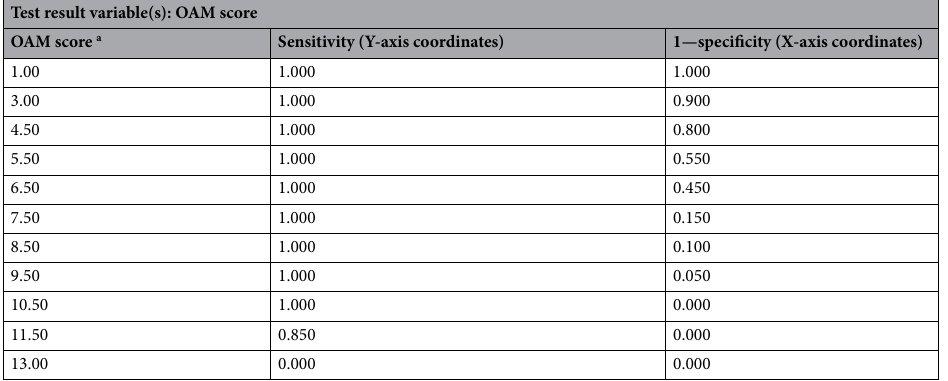
Table 7. Sensitivity and 1-specificity values at different AMS, calculated on the basis of the ROC curve (Coordinates of the curve) in S–S kinship analysis by X-STR. The smallest OAM cutoff score value is the minimum observed test value minus 1, and the most considerable cutoff value is the maximum perceived test value plus 1. All the other cutoff values are the averages of two consecutive ordered observed test